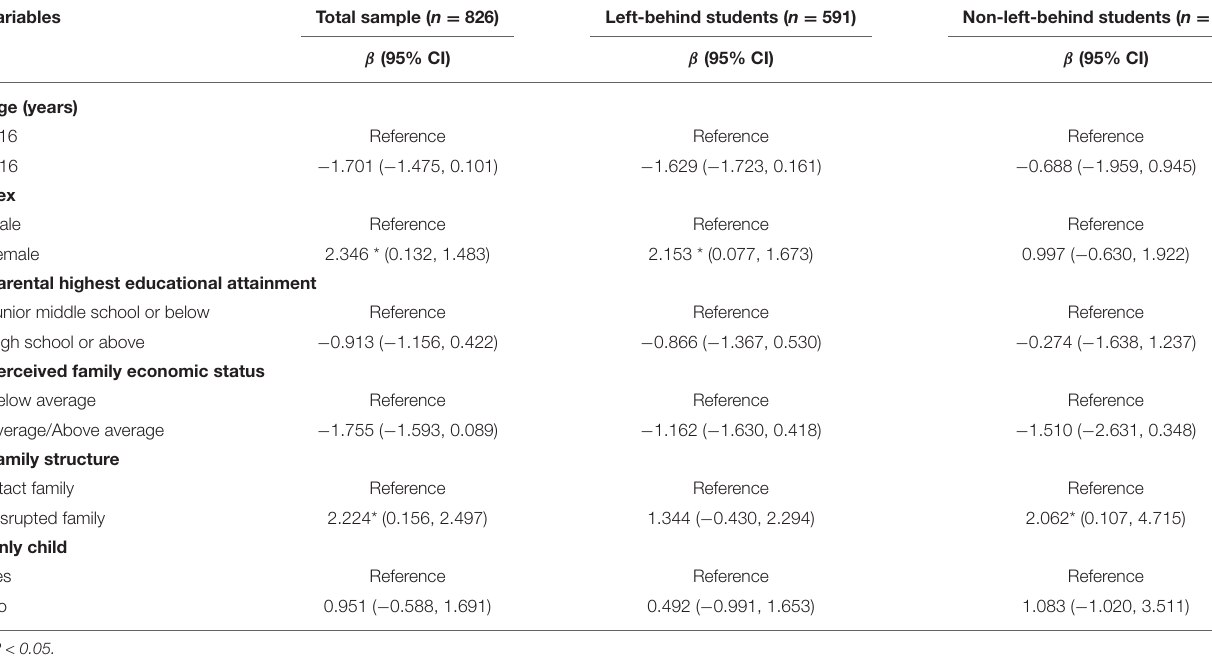
TABLE 2 | Association of demographic characteristics with depressive symptoms stratified by left-behind status ( N = 826).